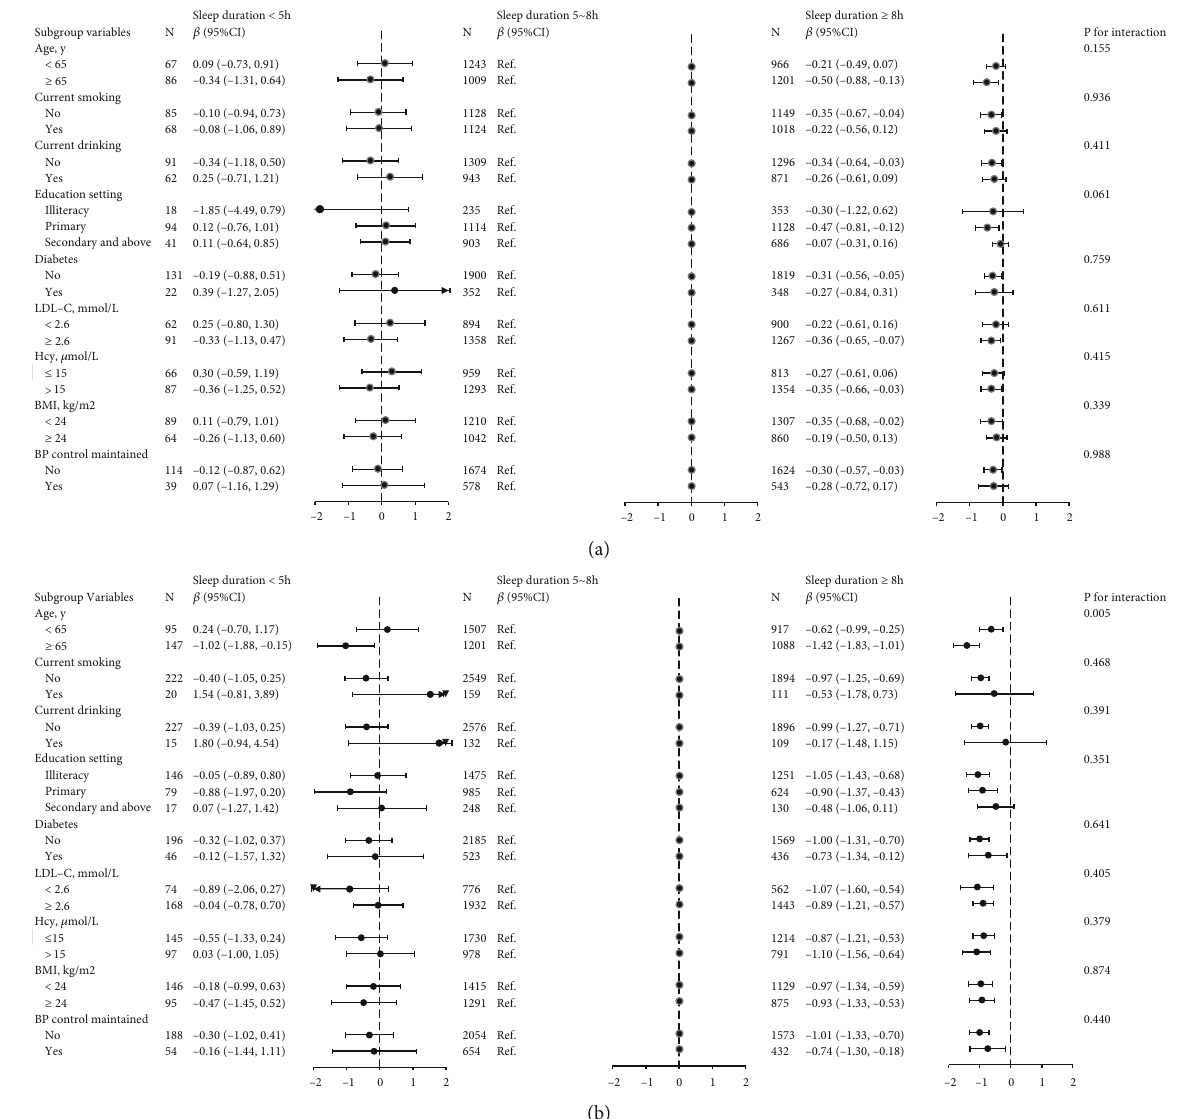
Figure 2: Strati fi ed analyses of the association between sleep duration and cognitive performance by sex. (a) Male. (b) Female. Adjusted for age, education, physical activity, current smoking, current drinking, BMI, SBP, DBP, coronary heart disease, diabetes, antihypertensive drugs, antidiabetic drugs, statin-lowering drugs, Hcy, TG, HDL-C, LDL-C, and eGFR, except for the variable that was strati fi ed. CI, con fi dence interval; BMI: body mass index; SBP: systolic blood pressure; DBP: diastolic blood pressure; Hcy: homocysteine; TG: triglycerides; HDL-C: high-density lipoprotein cholesterol; LDL-C: low-density lipoprotein cholesterol; eGFR: estimated glomerular fi ltration